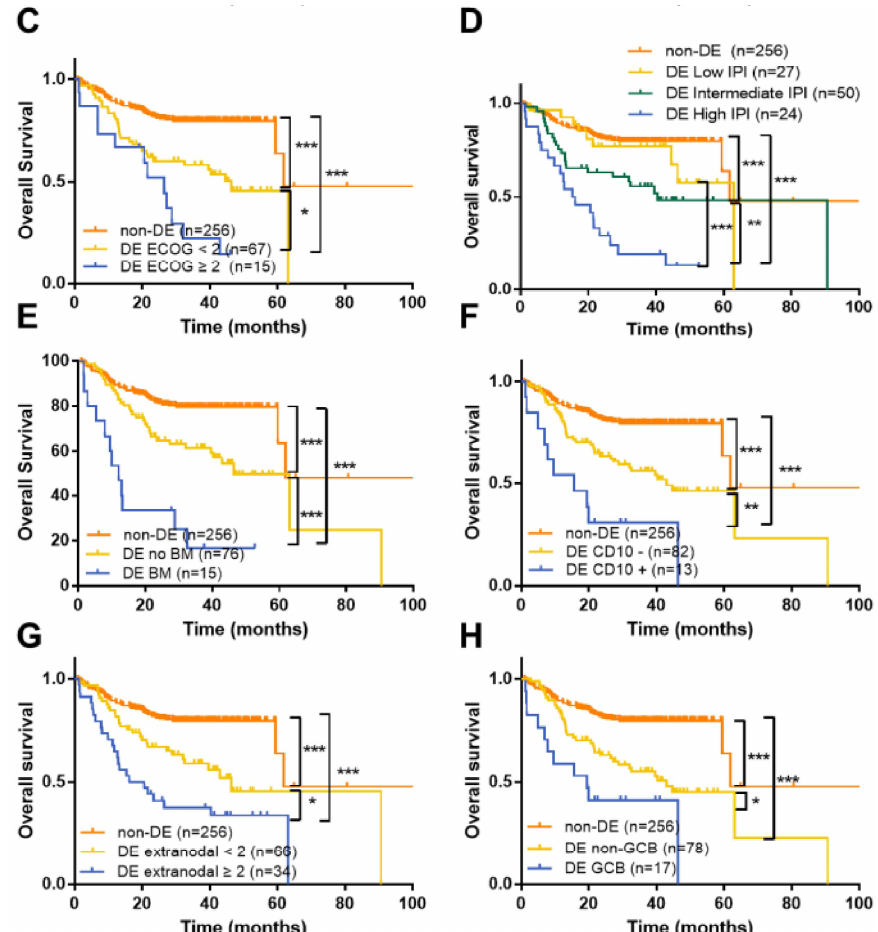
Figure 3. Survival of DLBCL patients treated with R-CHOP according to the DE status and clinicopathological parameters. OS of DLBCL patients treated with R-CHOP according to the DE status and age ( A ), serum LDH levels ( B ), ECOG PS ( C ), IPI score ( D ), BM involvement ( E ), CD10 expression ( F ), number of extranodal sites ( G ), and COO ( H ). * p < 0.05, ** p < 0.01, *** p <